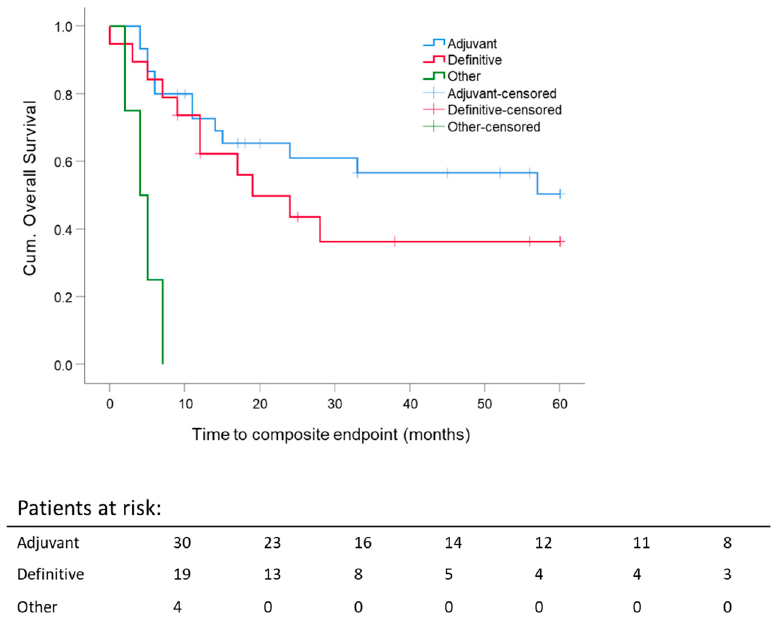
Figure 3. Five-year composite overall survival depending on the radiation settings: stratification for RT intention adjuvant/postoperative; definitive; others: palliative, early recurrence, additive. Kaplan–Meier curves for each analyzed group were calculated from the date of diagnosis. There was no impact of the chemotherapy schedule compared to patients without chemotherapy on five-year composite OS independent of RT intention. Thirty patients had only RT. Twenty patients received cisplatin 20 mg/m 2 /d at weeks 1 and 5 for five days or cisplatin 40 mg/m 2 weekly. Three patients were treated with cisplatin 100 mg/m 2 qd21 three times over the course of radiotherapy because of very locally advanced or systemically metastasized sinonasal tumors at the time of diagnosis. The latter showed a worse outcome (Figure 4).